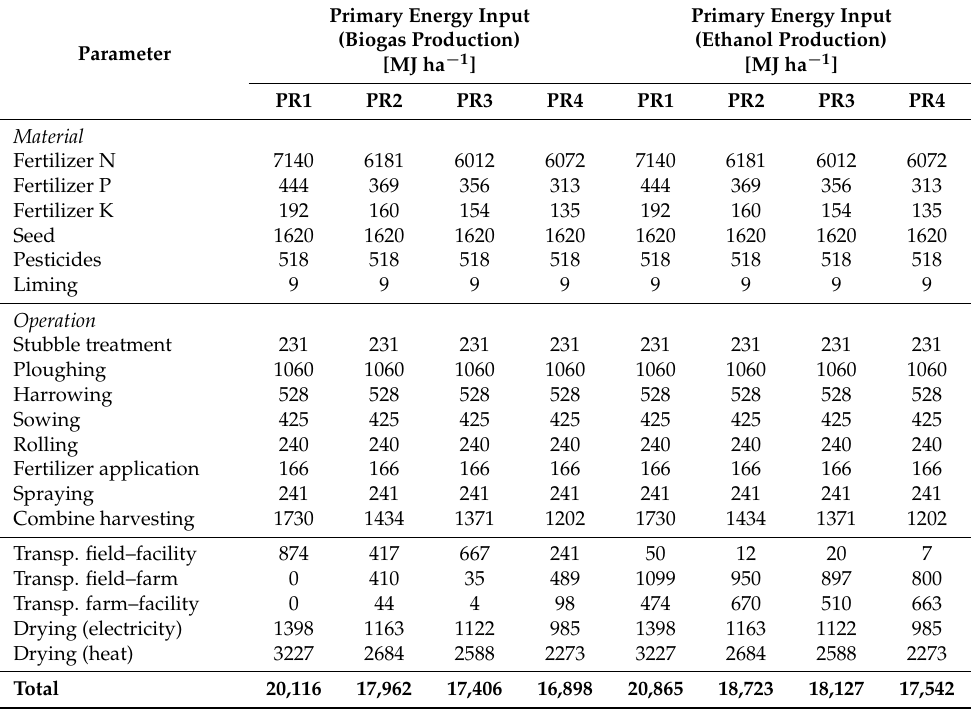
Table A5. Primary energy input in winter wheat grain production in the different production regions (PR) for the production of biogas and ethanol.